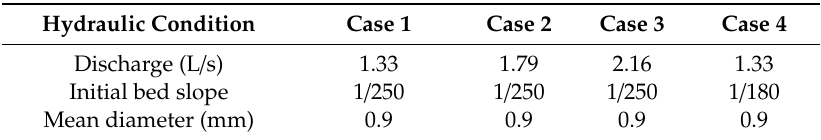
Table 2. Experimental